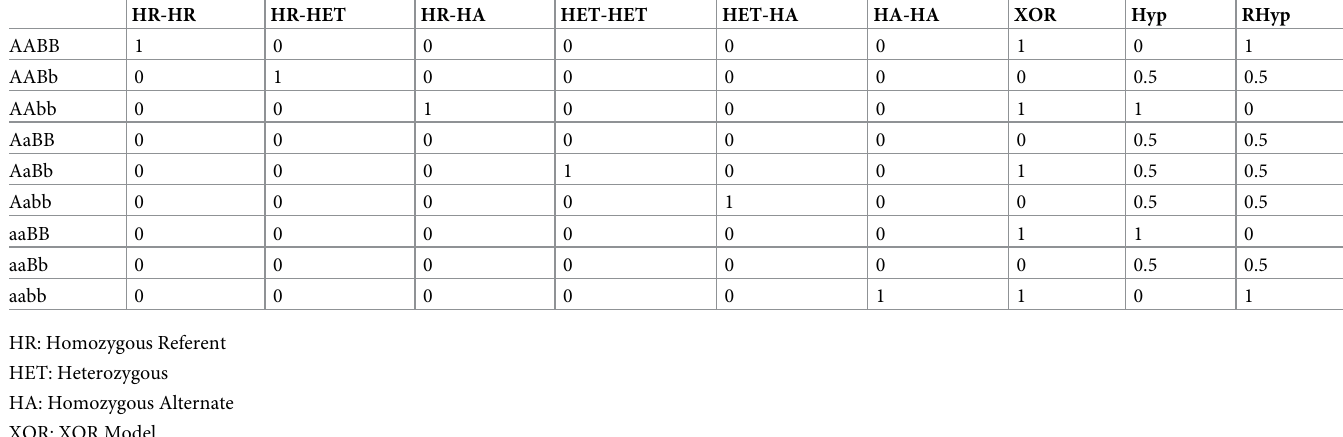
Table 3. Genotype-based simulated